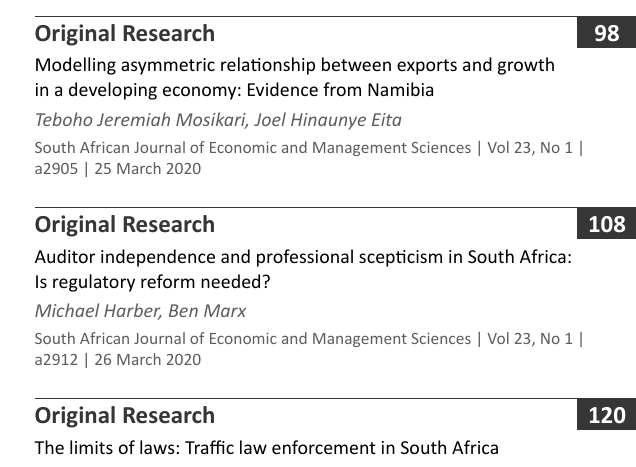
Modelling asymmetric relationship between exports and growth in a developing economy: Evidence from Namibia